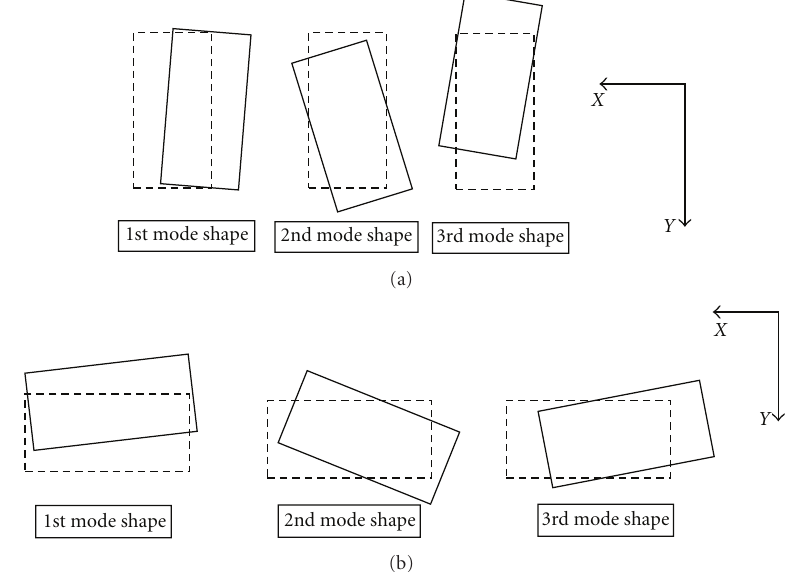
Figure 10: Planar views of the first three mode shapes: (a) building A and (b) building